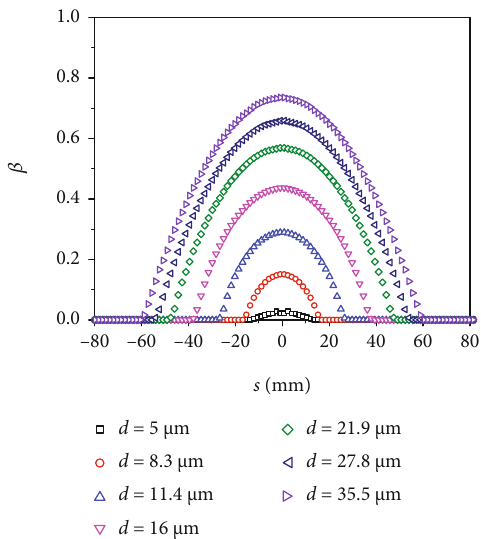
Figure 3: Collection e ffi ciency of the cylinder for various droplet sizes at the MVD of 16 μ m in Langmuir-D distribution.